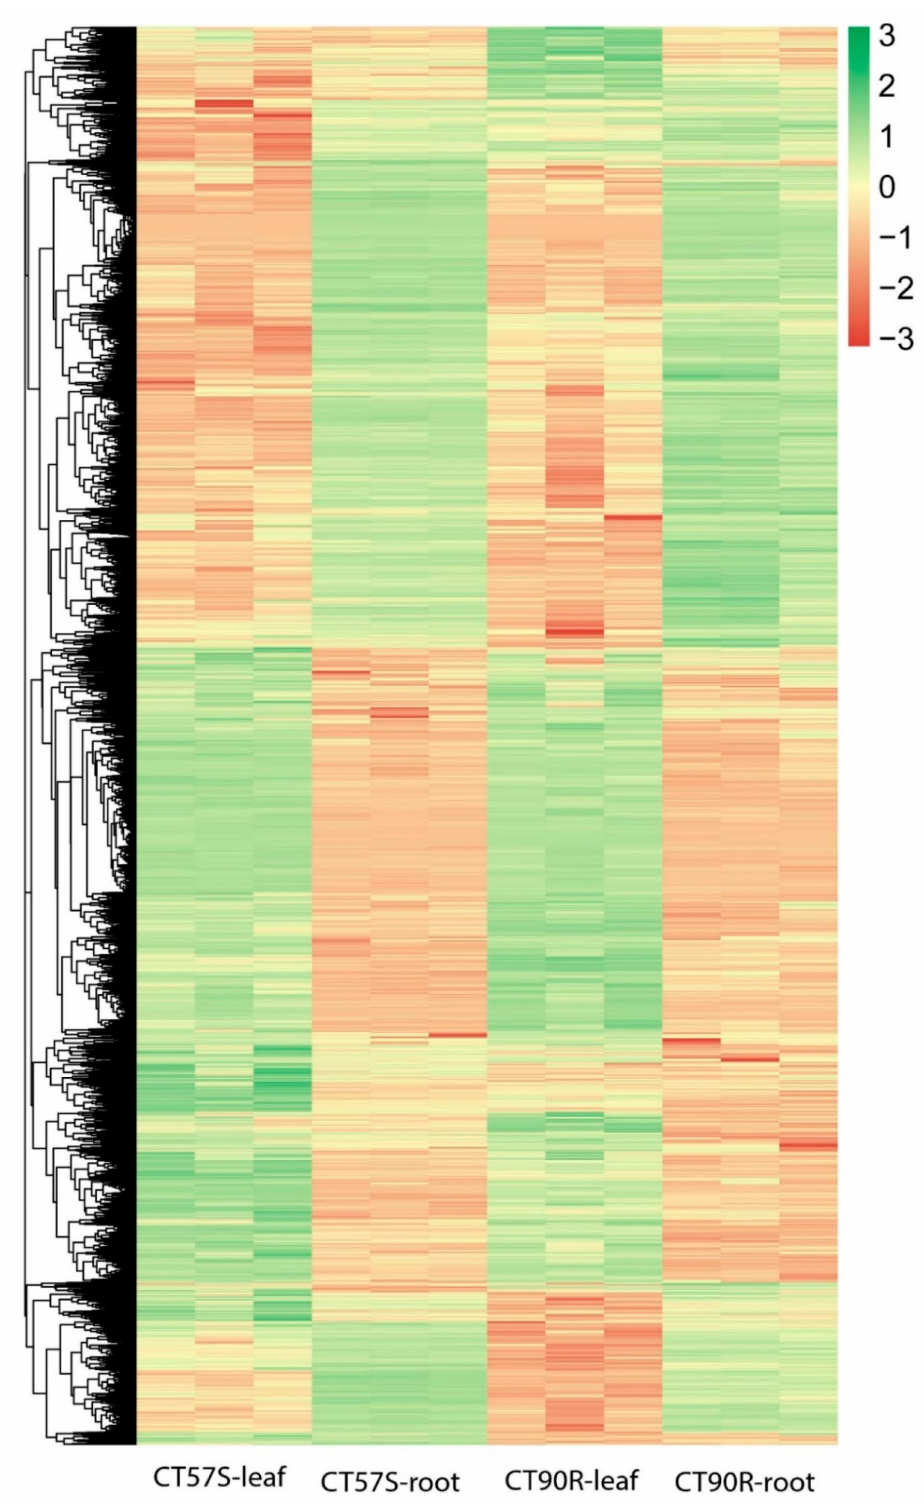
Figure 3. Heat map of DEGs in different samples. DEGs were identified from comparing a pair of CT57S-leaf vs. CT57S-root, CT90R-leaf vs. CT90R-root, CT57S-leaf vs. CT90R-leaf, and CT57S-root vs. CT90R-root. The color represents value of log 10